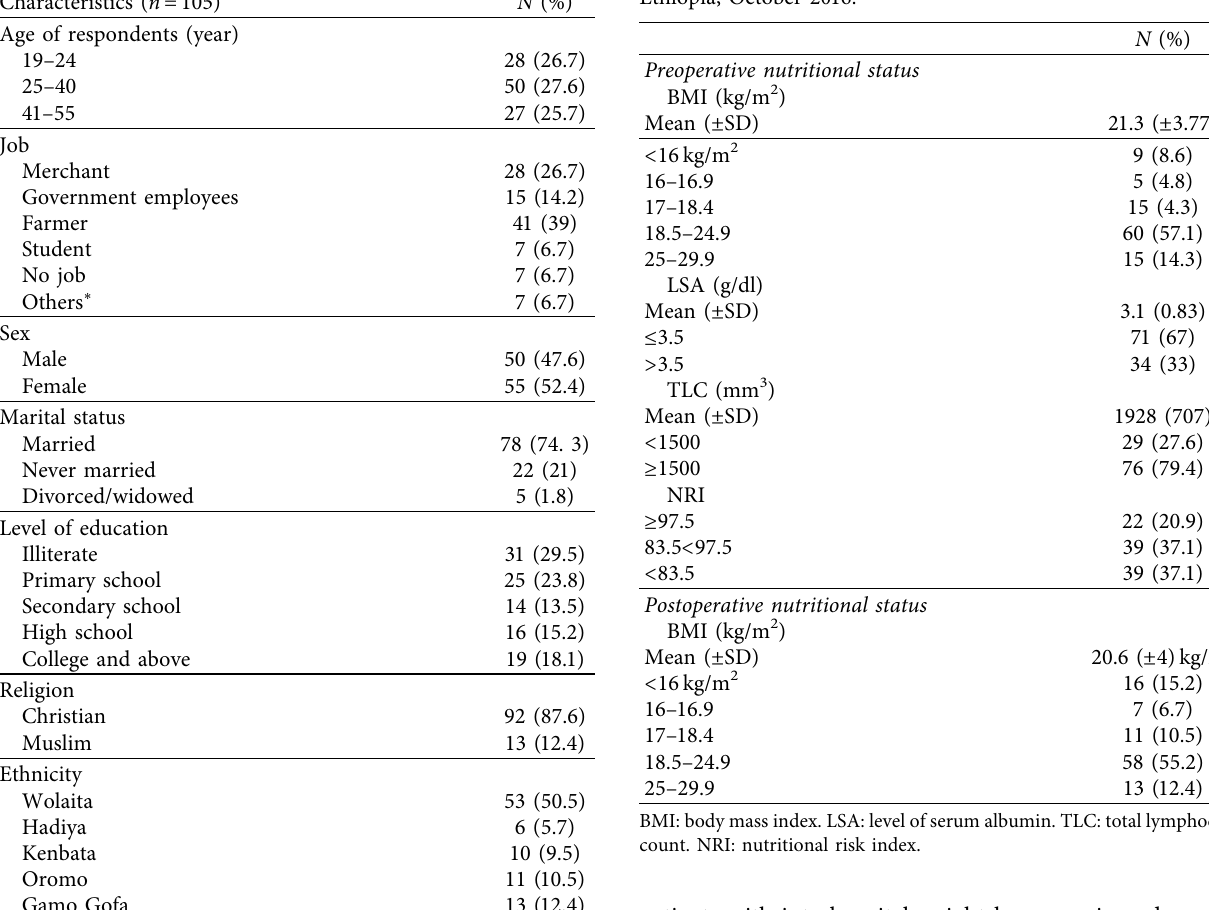
Table 3: Pre- and postoperative nutritional status of